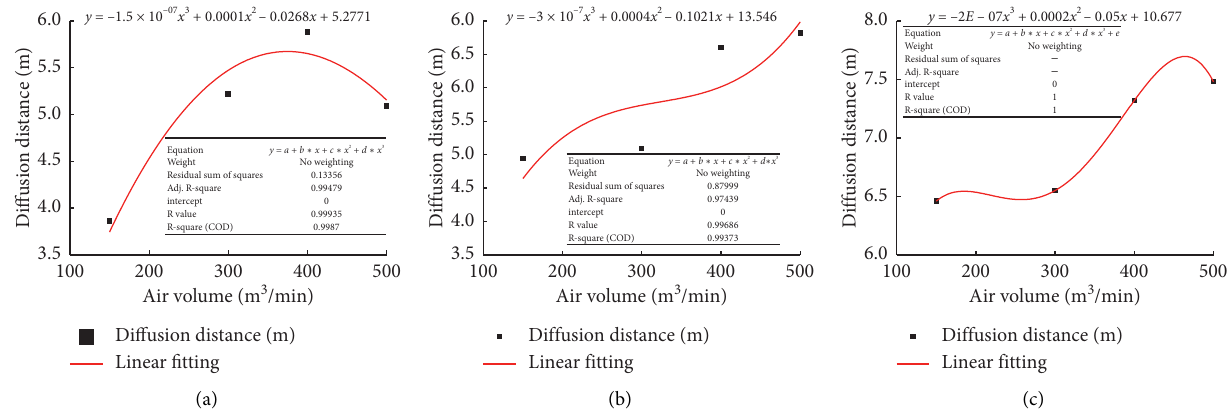
Figure 6: Influence of different heights on the diffusion distance of dust concentration in the working space: (a) H � 1m, (b) H � 1.5m, and (c) H � 2m.